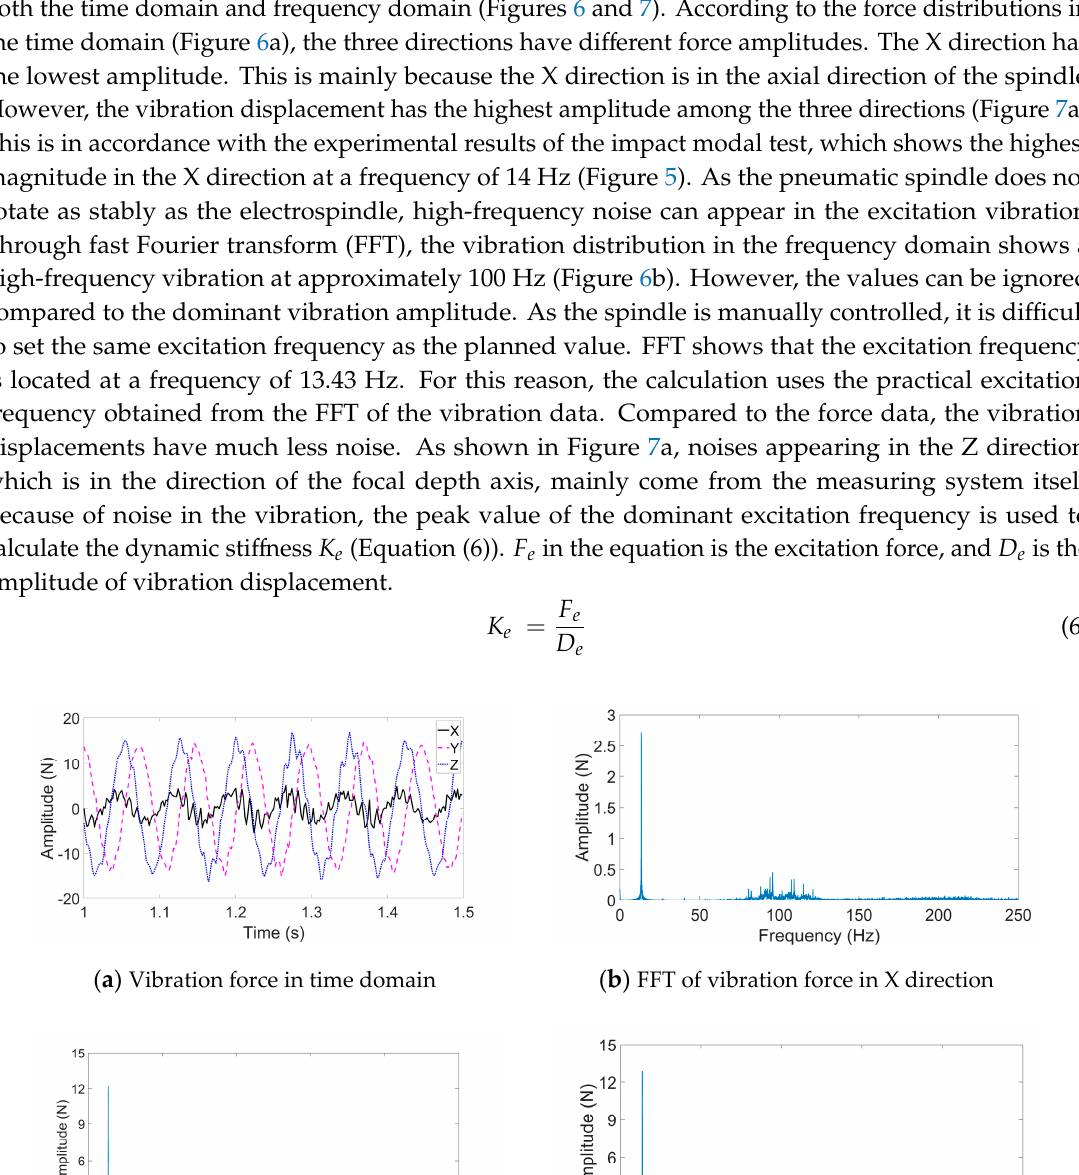
Figure 6. Vibration force in time and frequency domains under 14 Hz excitation frequency.